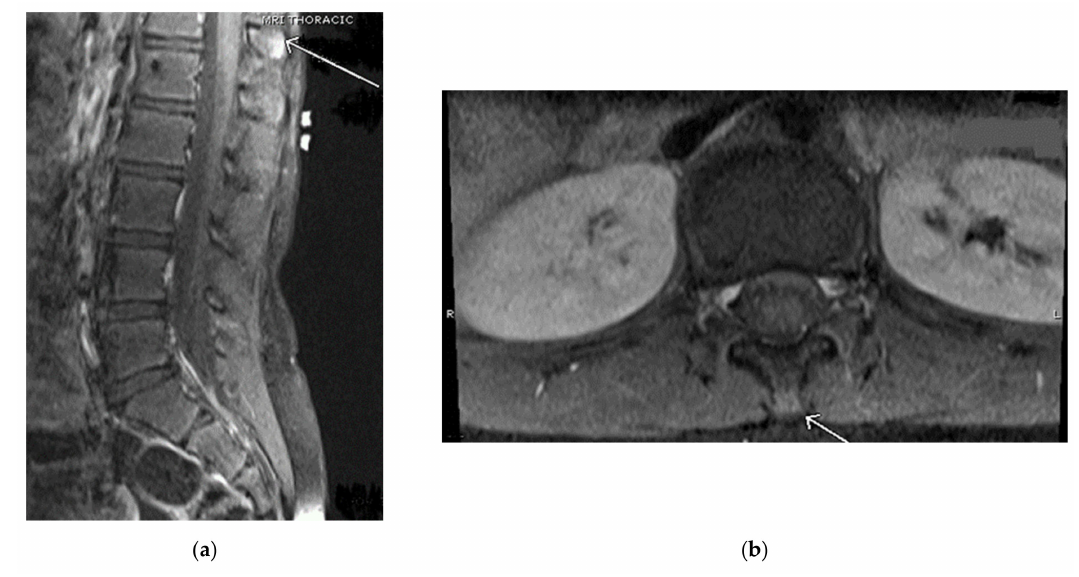
Figure 1. ( a ) Magnetic resonance imaging (MRI) thoracic spine sagittal view shows an arrow pointing to signal abnormality at the tips of the spinous processes in the thoracolumbar junction region, particularly at T12. ( b ) MRI lumbar spine axial view shows an arrow pointing at mild hyperintensity in the T12 spinous